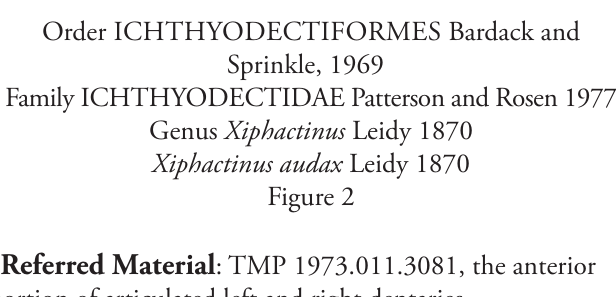
Referred Material : TMP 1973.011.3081, the anterior portion of articulated left and right dentaries. Figure 1. A) Summary stratigraph- ic chart for the Santonian to early Campanian of northwestern Alberta. B) Maps showing, counter-clockwise from top right: location of Alberta within Canada; location of regional map of Grande Prairie area within Al- berta; location of fossil site along Ka- kut Creek, northeast of Grande Prai- rie. Location of TMP 1973.011.3081 is marked with an